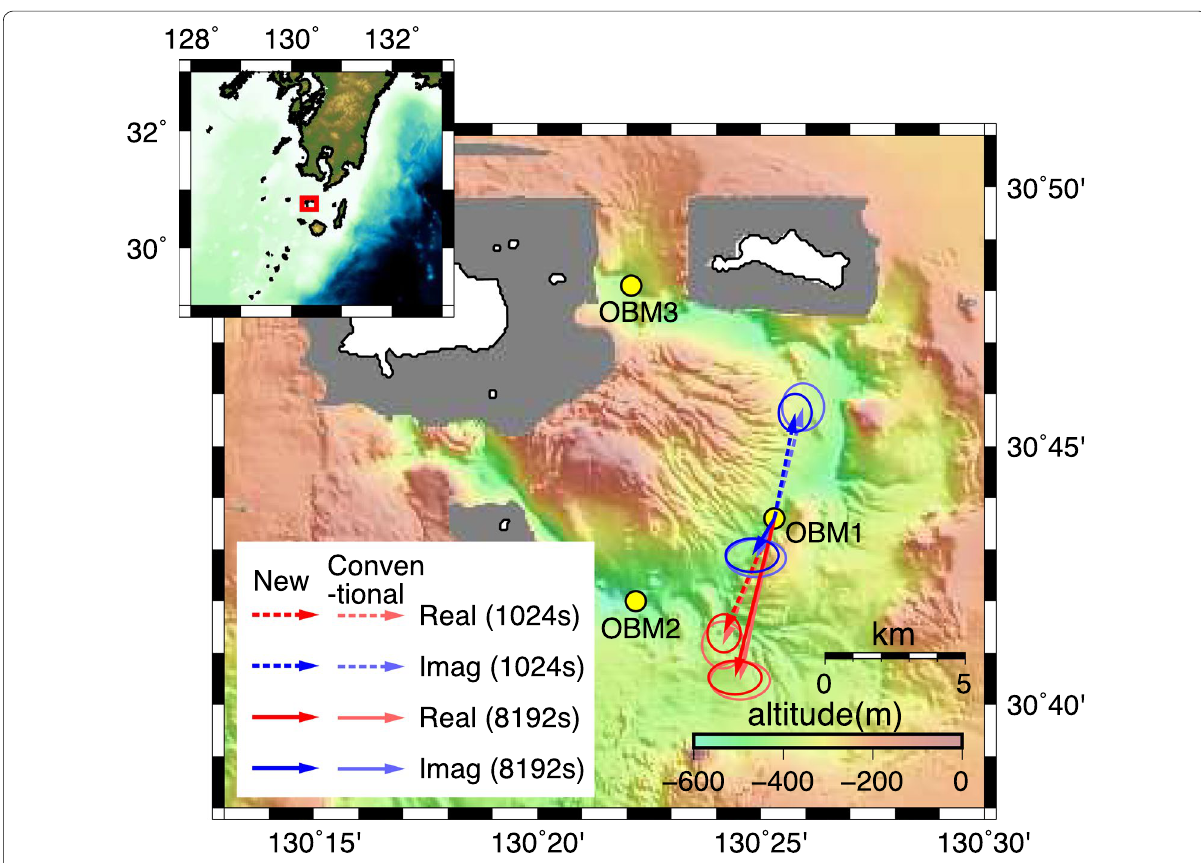
Fig. 2 A map around the Kikai caldera showing seafloor observation sites OBM1, OBM2, and OBM3 where the prototype models of the magnetometer system were operated. The conventional magnetometer was also operated at site OBM1. The arrows indicate a comparison of Parkinson’s induction vectors between the new and conventional magnetometer systems at OBM1. Length of the induction vectors in the legend is 0.25. The ellipses around the head of arrows denote 95% confidence limit of the induction